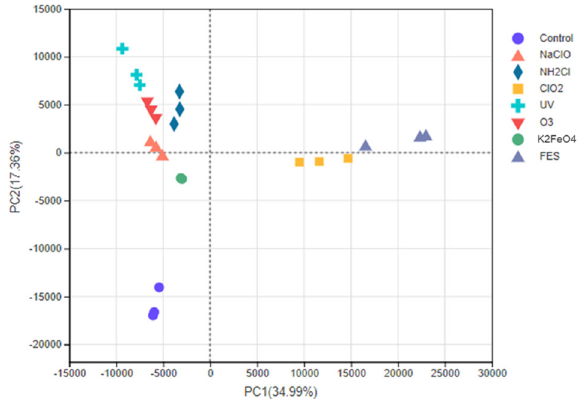
Fig. 5 Principal component analysis (PCA) of microbial commu- nities. Microbial communities of DRB bio fi lms were displayed in a two-dimensional chart by PCA algorithm. n = 3 for all the experi- ment groups and the control